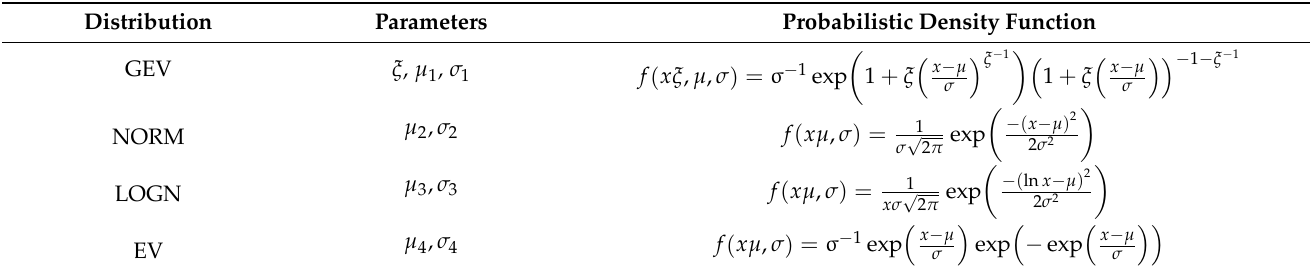
Table 6. Parameters of the four probabilistic distribution function.